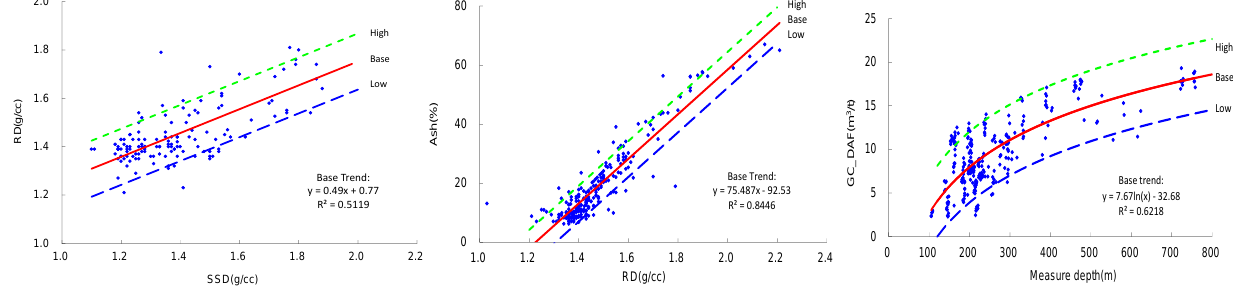
Figure 3—Parameters uncertainty analysis.